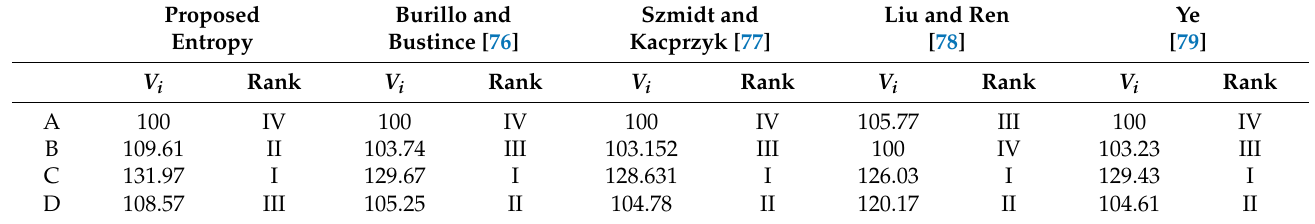
Table 4. Comparison of V i and rank with different entropies.